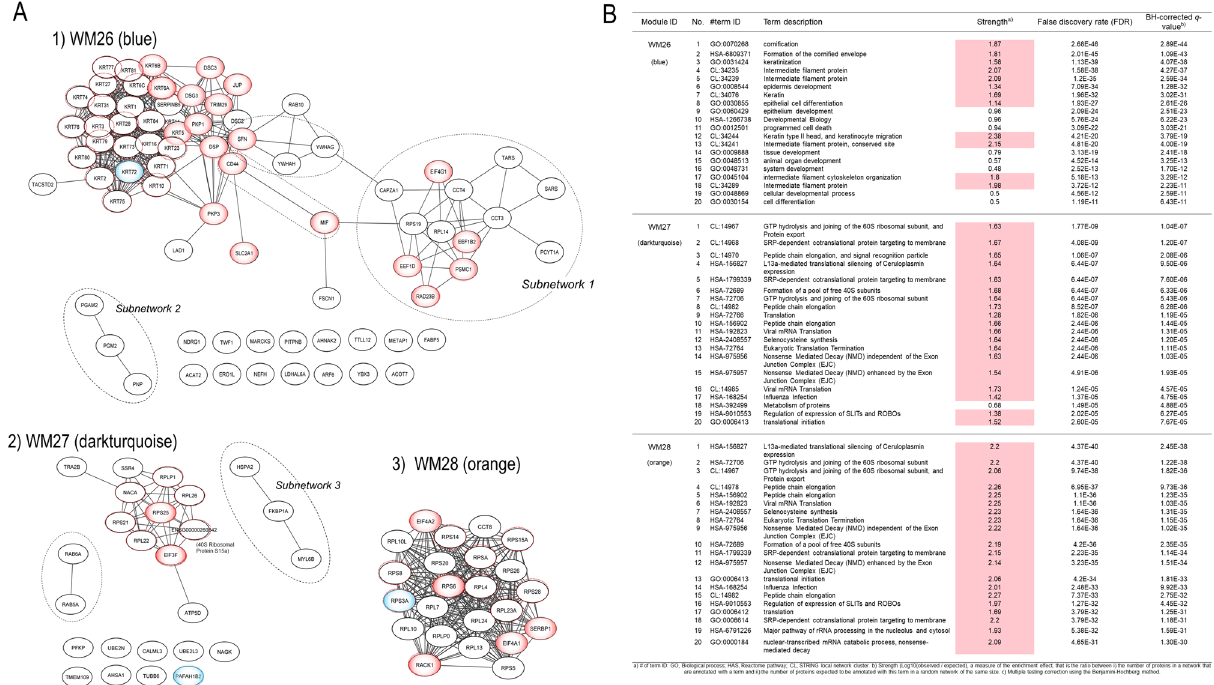
Figure 3. Data-driven protein co-expression networks and pathway enrichment results obtained for the lung SqCC trait. ( A ) The co-expression networks of respective modules: (1) WM26, (2) WM27, and (3) WM28 modules. Circle nodes in blue gradation and dotted red represent eigen proteins and/or hub proteins, respectively, for each module, and circle nodes in red gradation also indicate key proteins in the network modules. Dashed circles in black denote subnetworks and protein groups. ( B ) Among pathways enriched for the protein core networks obtained for biological process (GO) and Reactome pathways, the top 20 pathways are presented in the order of significance by the q -value. The dashed circles denote subnetworks and protein